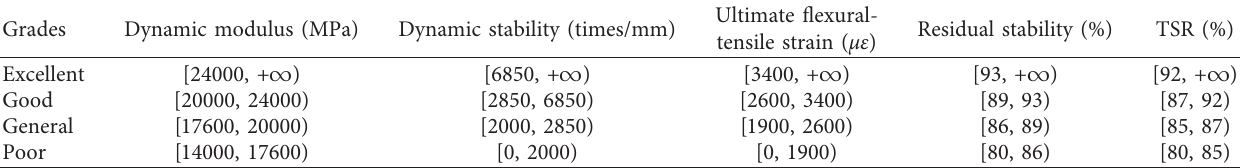
Table 2: Classification standard of low-grade high modulus asphalt mixture.